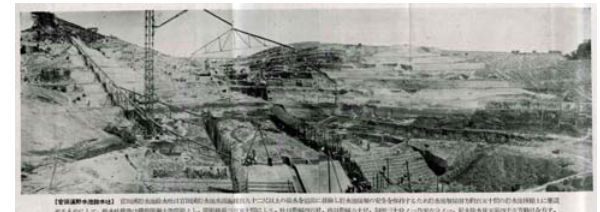
Figure 2. Construction of the Jianan Irrigation System’s reservoir